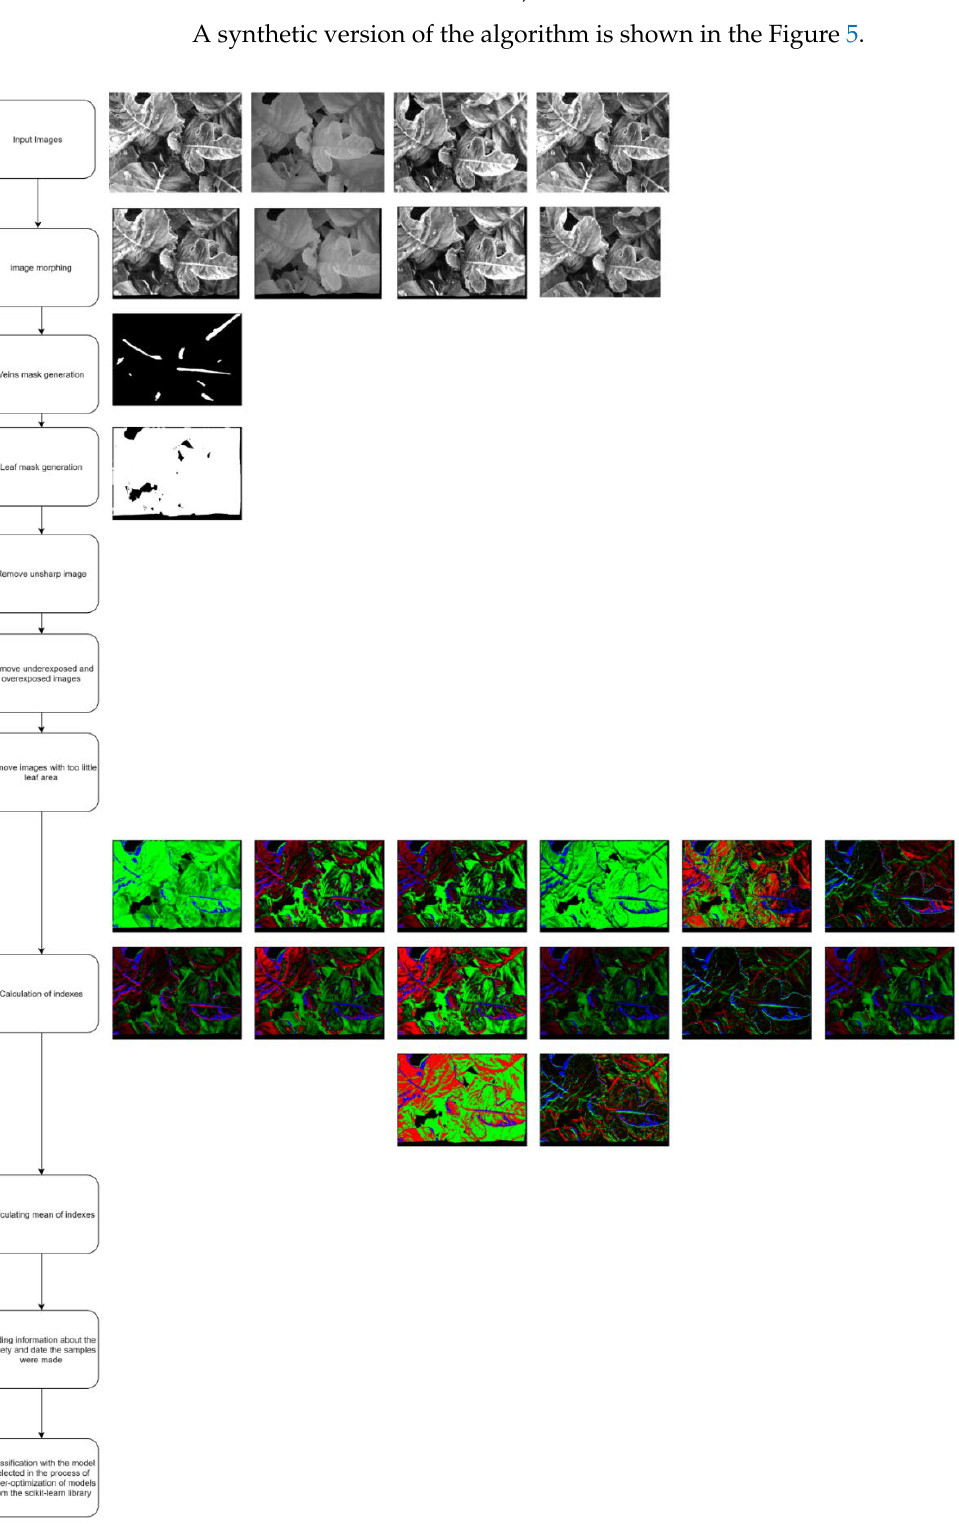
Figure 5. Multispectral measurement analytical algorithm.